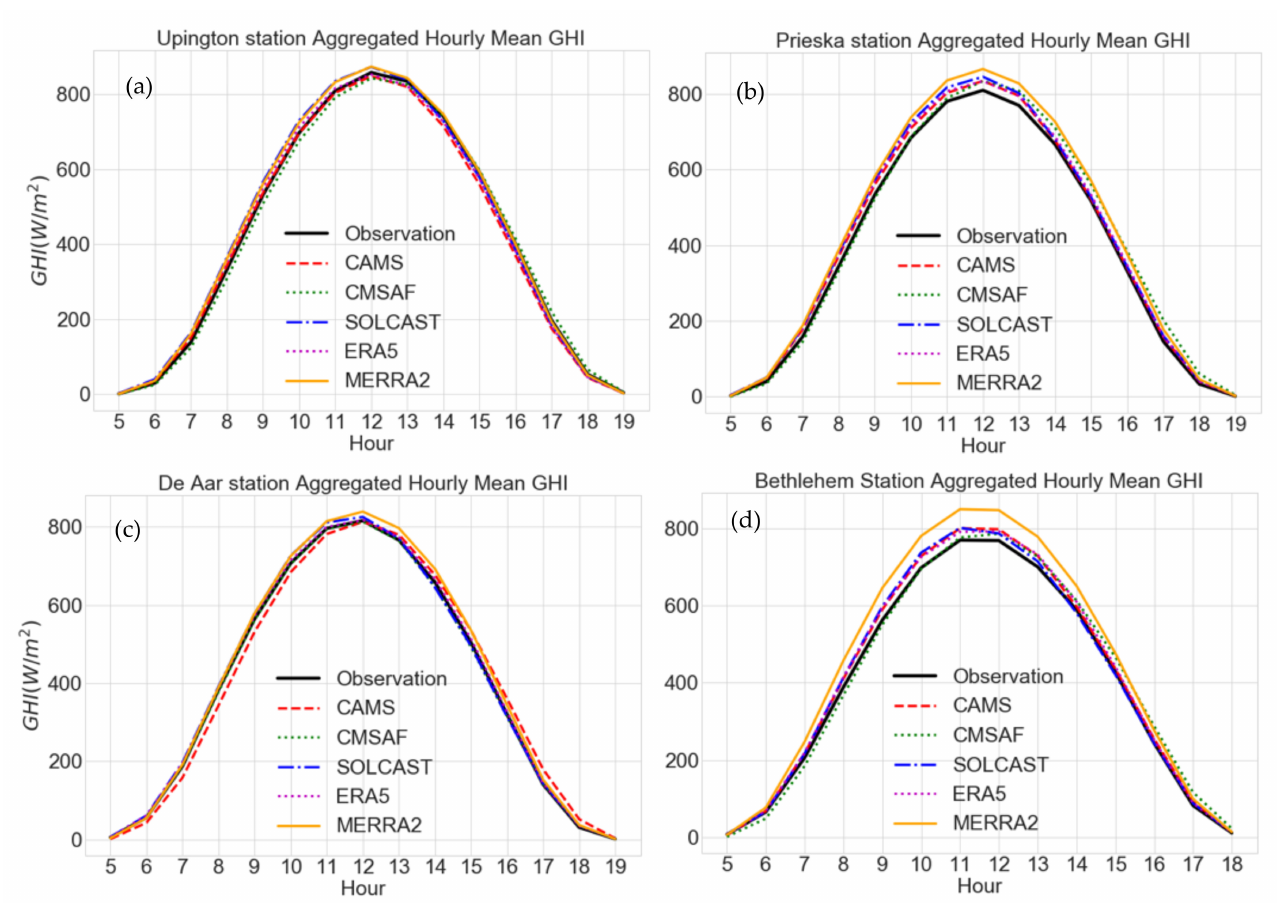
Figure 6. Aggregated measured and estimated hourly GHI values in De Aar ( a ), Bethlehem ( b ), Prieska ( c ), and Upington ( d ). The aggregated GHI Observation period for each station is given in Table